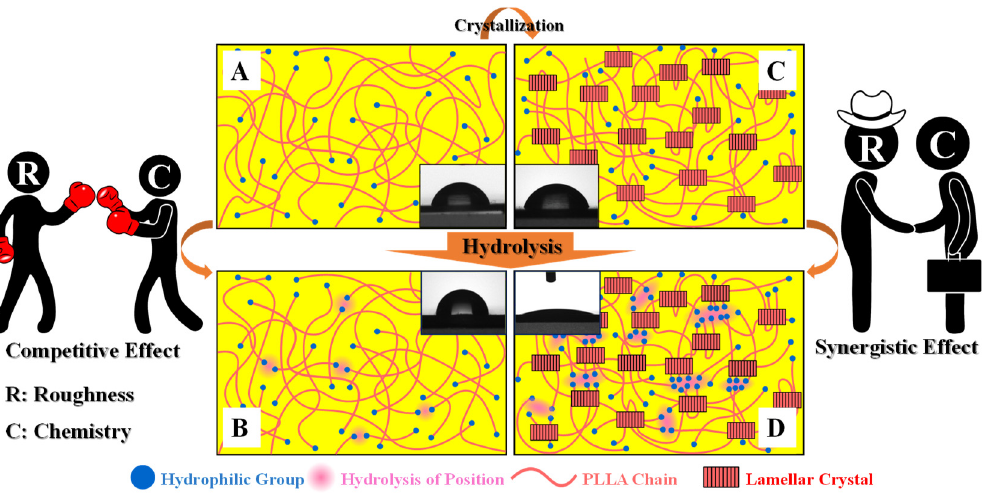
Figure 7. Schematic diagram of PLLA surface alkali hydrolysis mechanism: ( A ) Untreated amorphous PLLA film surface; ( B ) amorphous PLLA film surface after hydrolysis; ( C ) untreated crystallized PLLA film surface; ( D ) crystallized PLLA film surface after hydrolysis.